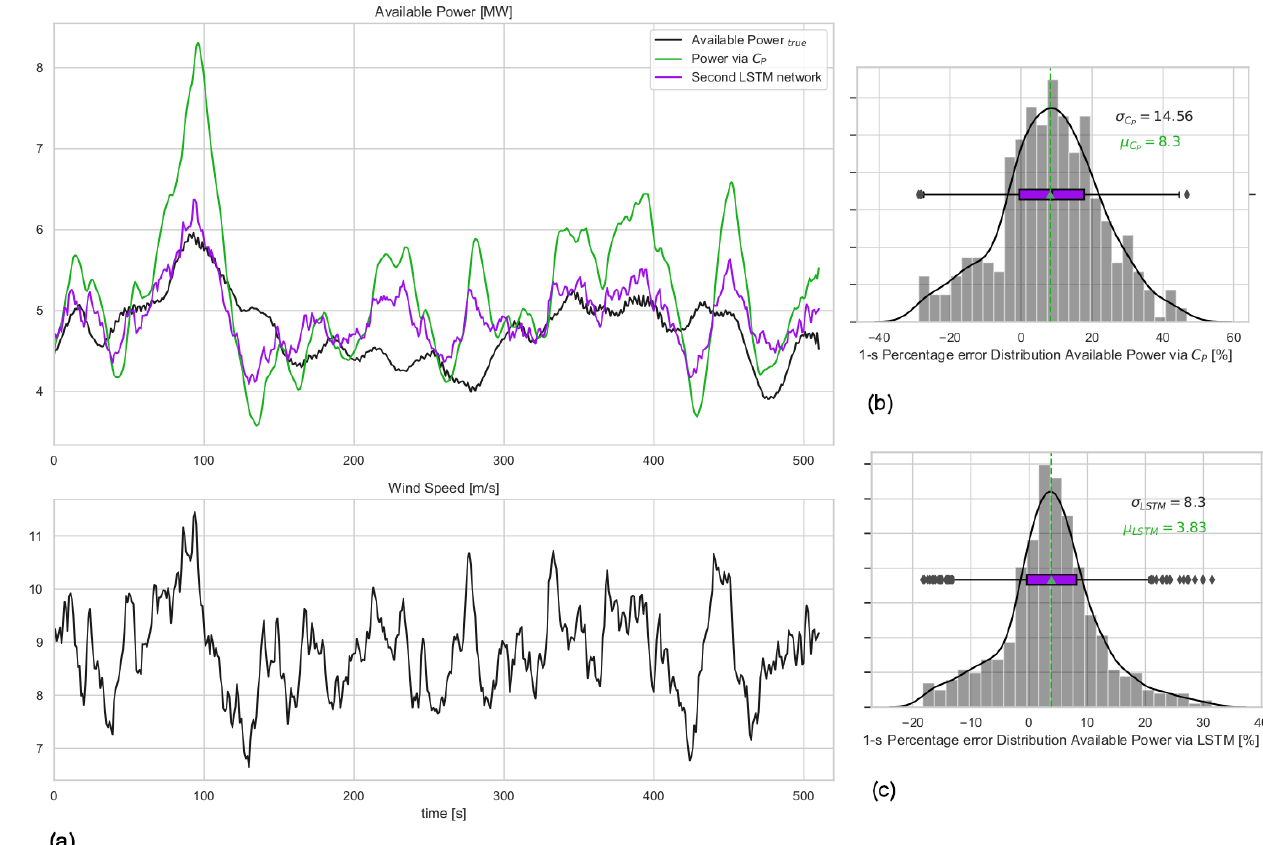
Figure 8. (a) The 1Hz time series of available power and wind speed for the second test case: second-wise comparison of the available power of the 10MW turbine for mean wind speed = 9ms − 1 and mean TI = 10% flow case represented in Fig. 7. (b) Available power estimation error via direct C P curve interpolation of wind speed; (c) error distribution of the second LSTM model with lag = 29s. µ and σ are the mean and the standard deviation of the 1Hz percentage error